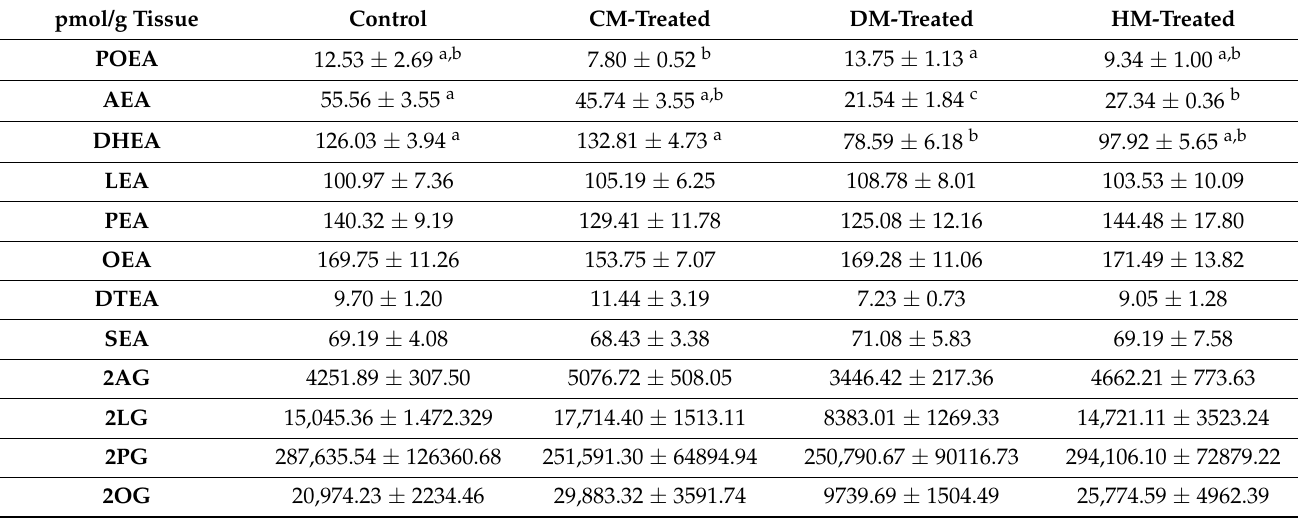
Table 3. Changes of endocannabinoidome profile in heart of rats fed with CM, DM or HM diet supplementation. pmol/g Tissue Control CM-Treated DM-Treated